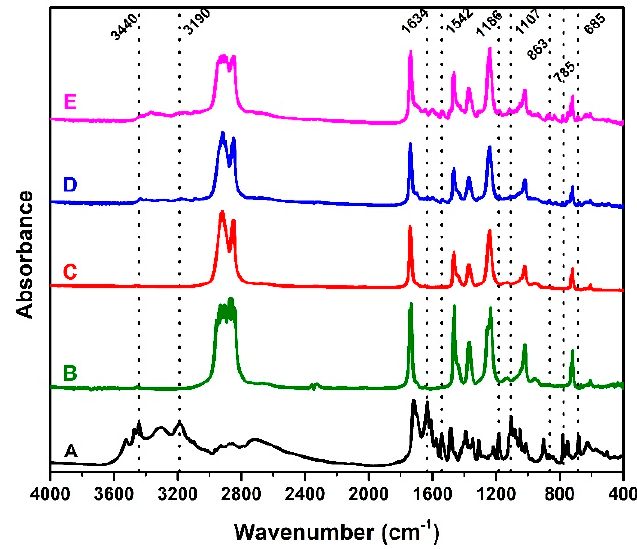
Figure 5. ATR-FTIR spectra of ACV (A), EVA pellet (B) and 3D-printed samples EVA-P (C), EVA-P10 (D), and EVA-P20 (E).